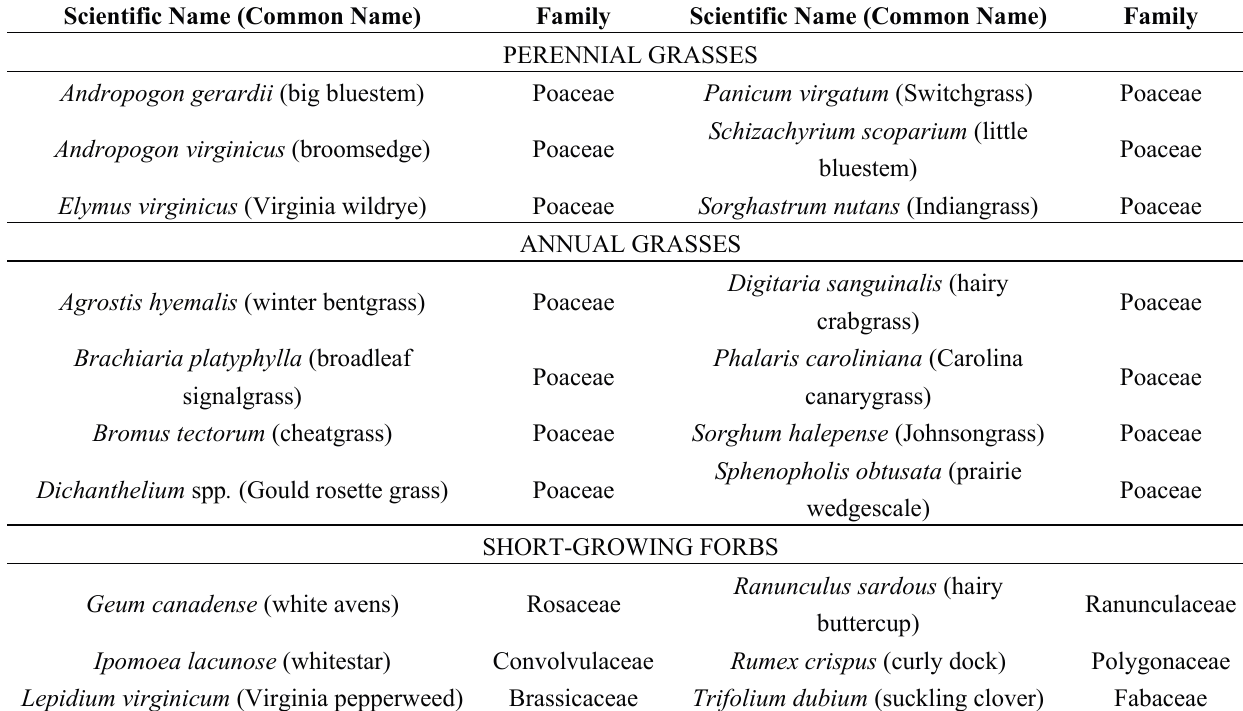
Table 1. Plant species and their respective families, grouped by plant type, recorded in the mixed native warm-season grass stands in June 2009 and